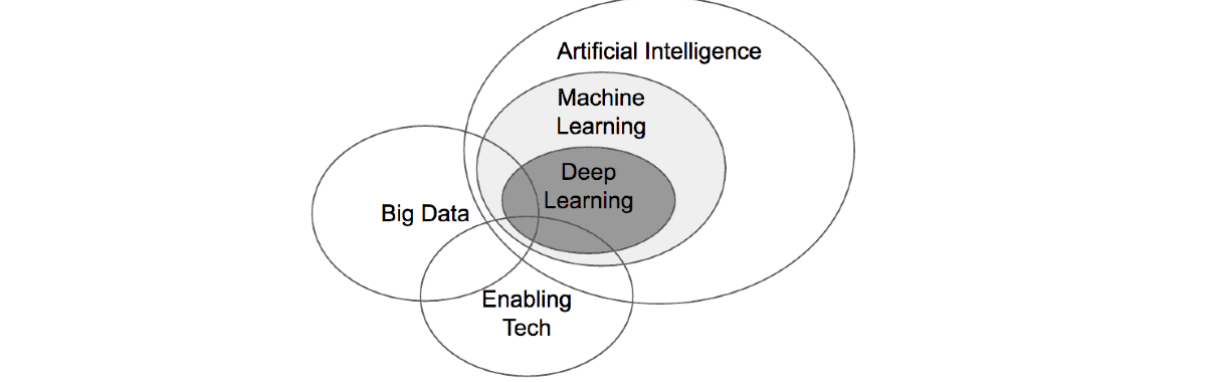
Figure 1. Venn diagram showing the relationship between neural networks, machine learning, and artificial